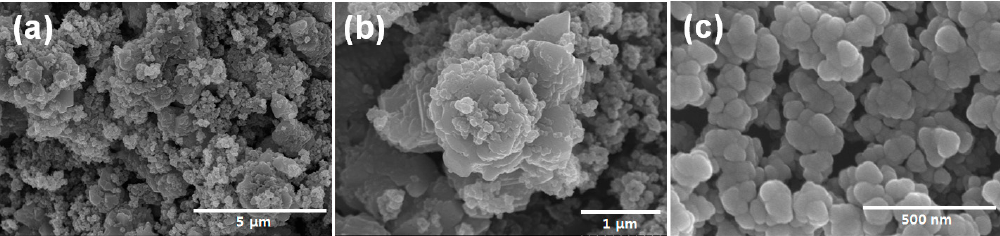
Figure 14. FE-SEM images of composite particles of carbonated product: ( a ) at low magnification; ( b ) at high magnification; and ( c ) clustered SiO 2 nanoparticles.